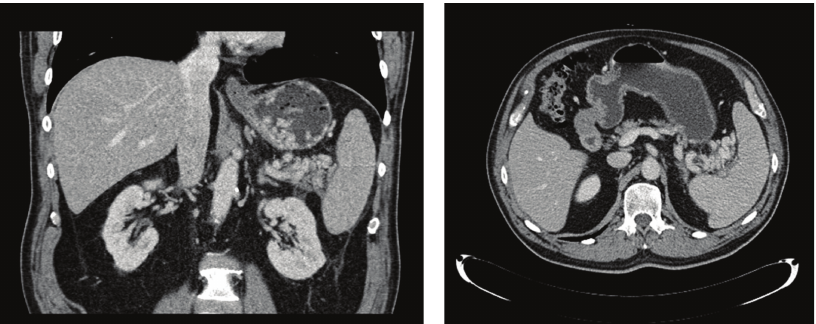
Figure 2: Cluster of varices in the left upper quadrant medial to the splenic hilum with multiple gastric varices within the gastric